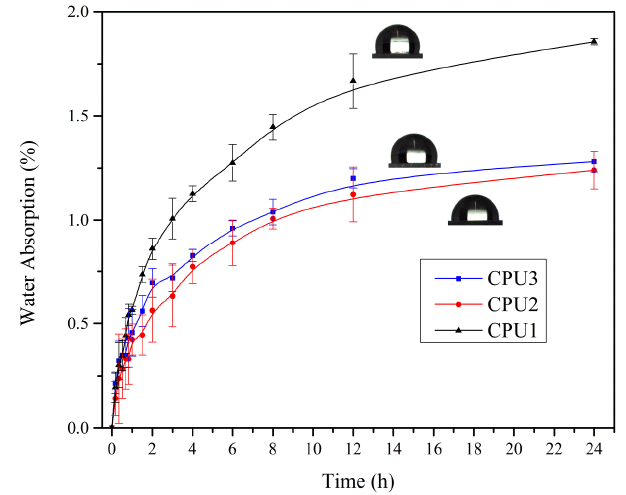
Figure 5. Water adsorption behaviors of CPUs (inserted photos are the illustrations of their water contact angles).